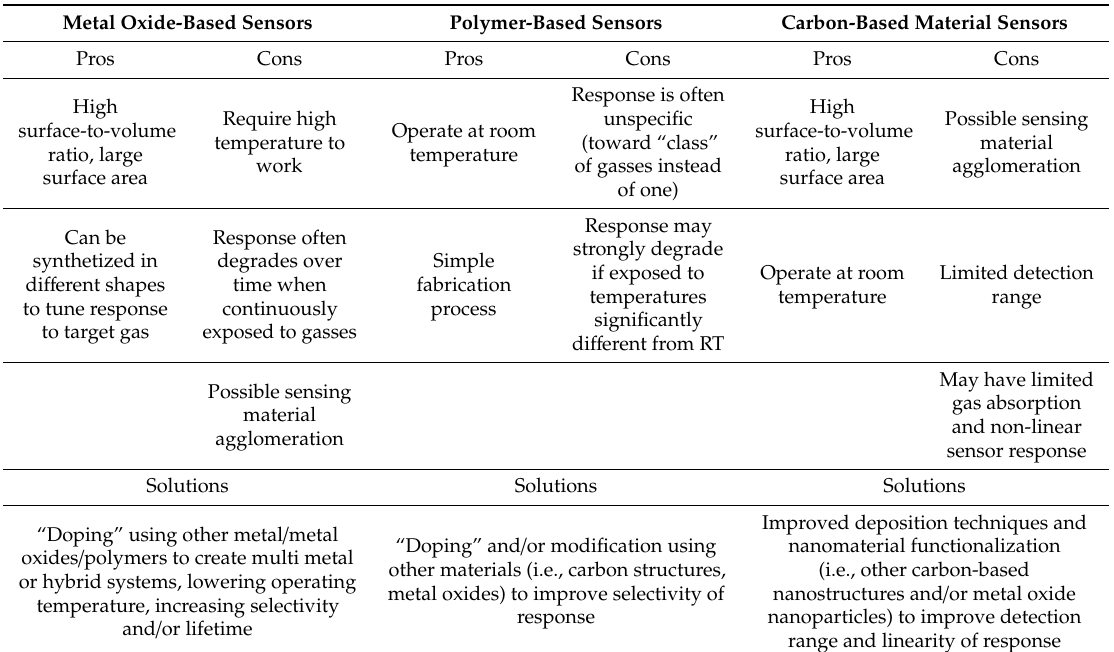
Table 3. Advantages and disadvantages of metal oxide, polymer, and carbon nanomaterial-based gas